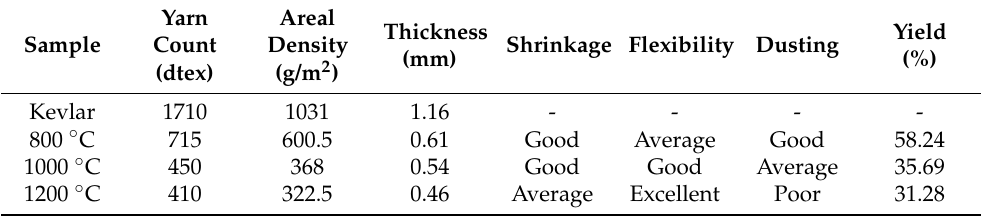
Table 1. Effect of carbonization temperature on physical properties of activated carbon